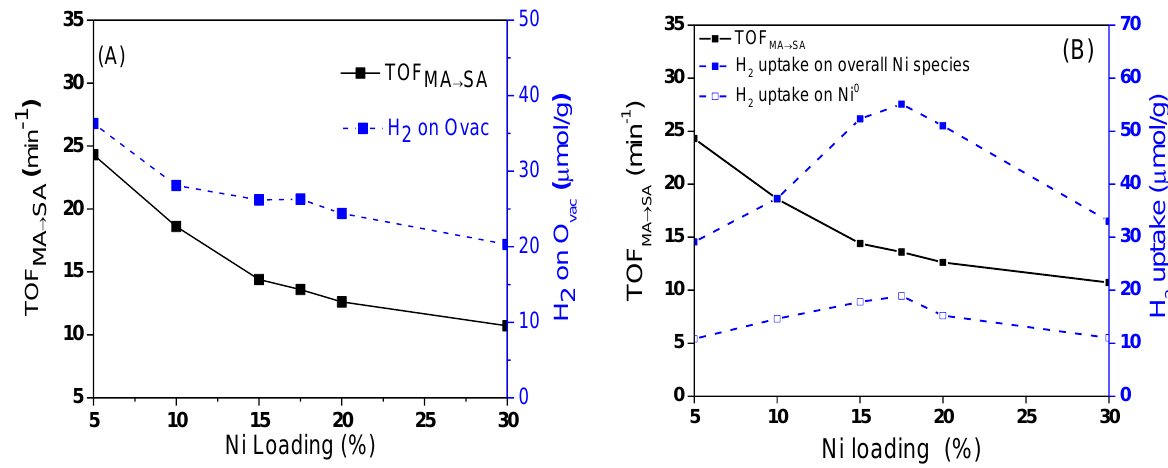
Figure 12. Effect of Ovac ( A ) and surface Ni species ( B ) on the TOF MA → SA over the xNi/CeO 2 cata- lysts.